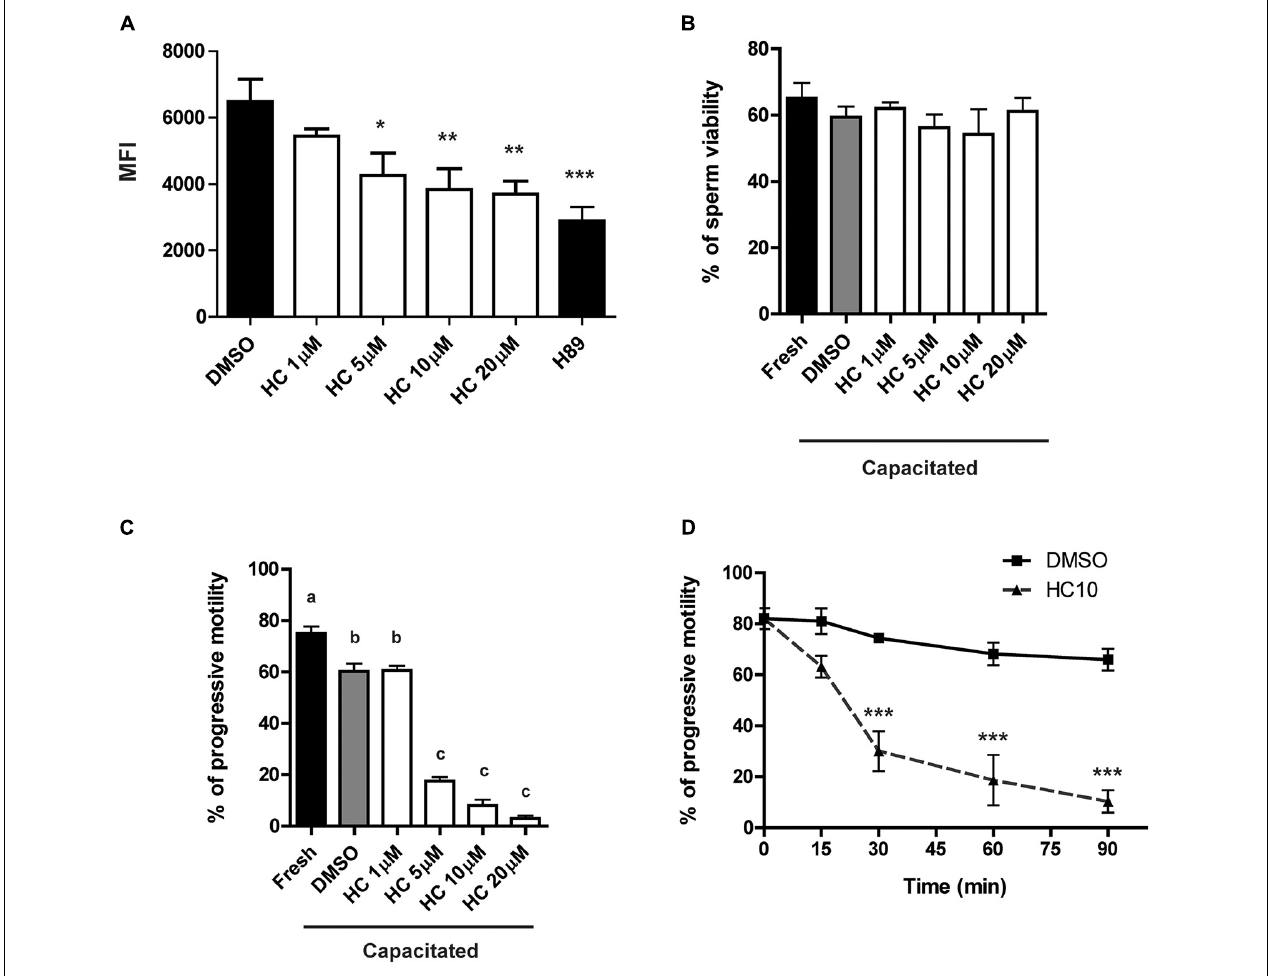
FIGURE 1 | Effect of HC on sperm intracellular Ca 2 + levels and progressive motility during capacitation. Cauda epididymal sperm were incubated for 90 min under capacitating conditions in medium containing either different concentrations of HC (1, 5, 10, and 20 µ M) or DMSO (vehicle) as a control, and then subjected to different analysis. (A) Intracellular Ca 2 + levels determined by flow cytometry using Fluo 4-AM and PKA inhibitor H89 as a positive control of Ca 2 + entry inhibition. Results are shown as mean fluorescence intensity (MFI). (B) Percentage of sperm viability determined by eosin staining. (C) Percentage of sperm progressive motility determined by light microscopy ( × 400). Values not sharing the same letter are significantly different. (D) Percentage of sperm progressive motility as a function of incubation time in a medium containing HC 10 µ M. Samples were analyzed as described in panel (C) . Data are mean ± SEM of at least n = 3 independent experiments; * p < 0.05; ** p < 0.005; *** p < 0.0005 vs.